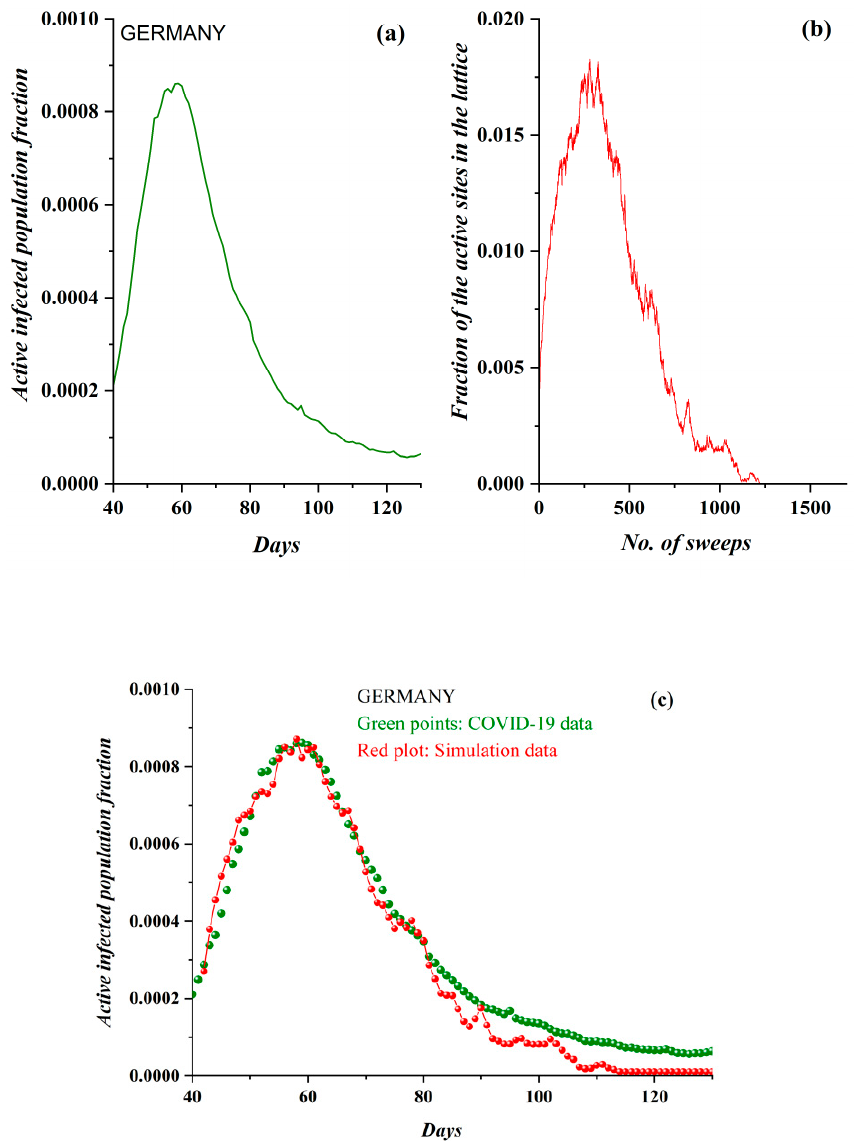
Figure 5. ( a ) The fraction of the active COVID-19-infected population daily in Germany (after 5 March 2020). Again, the three phases are clearly distinguished. ( b ) The fraction of active lattice sites (order parameter of the SODM) vs. the number of lattice sweeps is shown. ( c ) The COVID-19 epidemic data for Germany in green points, fitted by the proposed a self-organized diffusion model (SODM) simulation data, in red points. Each day corresponds to 22 sweeps.